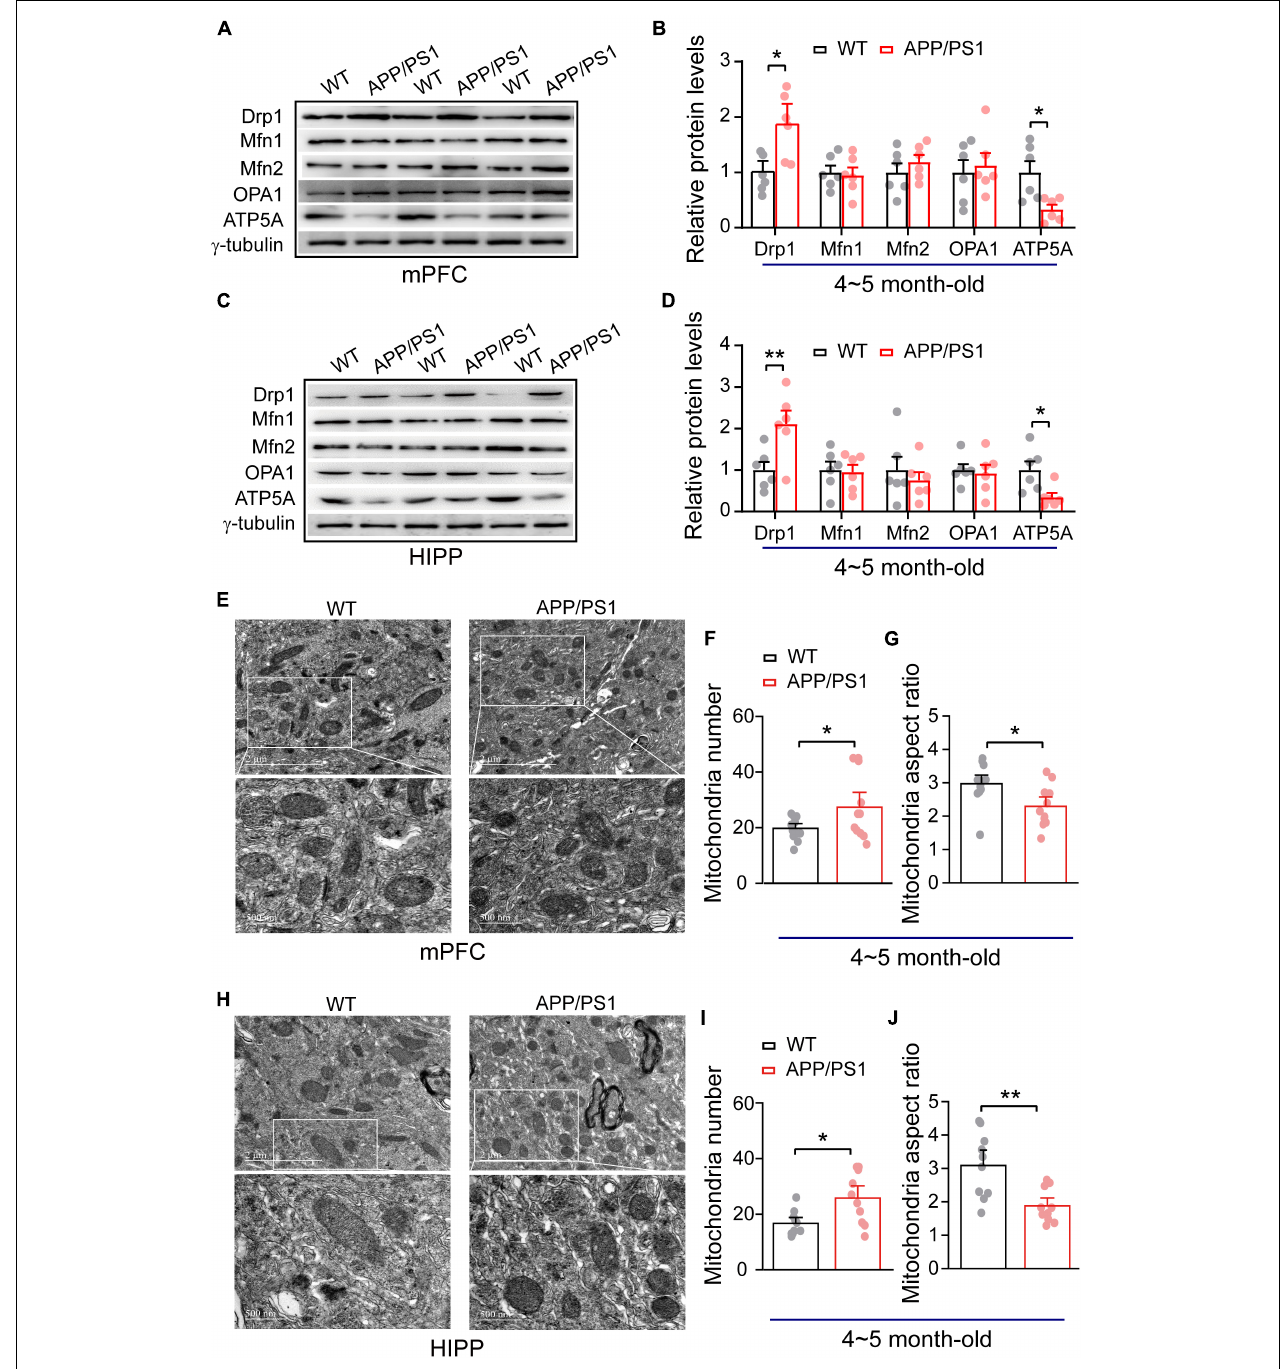
FIGURE 1 | Alteration in mitochondrial fission, ATP synthase protein expression and mitochondrial morphology in the mPFC and HIPP of 4 ∼ 5-month-old APP/PS1 mice. (A) Representative immunoblotting images of mPFC extracts and (B) quantification of blots indicate significantly increased levels of Drp1 and decreased levels of ATP5A, whereas fusion proteins Mfn1, Mfn2, and OPA1 remain unchanged in APP/PS1 mice compared with age-matched WT mice ( n = 6 mice per genotype; two repeats: two-sample t -test). (C) Representative immunoblotting images of hippocampus extracts and (D) quantification of blots indicate significantly increased levels of Drp1 and decreased levels of ATP5A, whereas fusion proteins Mfn1, Mfn2, and OPA1 remain unchanged in APP/PS1 mice compared with age-matched WT mice ( n = 6 mice per genotype; two repeats; two-sample t -test). (E) Representative TEM images of mitochondrial morphology from mPFC of WT and APP/PS1 mice. (F) Increased mitochondrial number but (G) reduced mitochondrial aspect ratio in the mPFC of APP/PS1 mice than WT mice ( n = 12 images for WT, 11 images for APP/PS1 mice; 3 mice per genotype: two-sample t -test). (H) Representative TEM images of mitochondrial morphology from HIPP of WT and APP/PS1 mice. (I) Increased mitochondrial number but (J) reduced mitochondrial aspect ratio in the HIPP of APP/PS1 mice than WT mice ( n = 10 images for WT, 10 images for APP/PS1 mice; 3 mice per genotype: two-sample t -test). Each value represents the mean ± SEM, * p < 0.05, ** p <